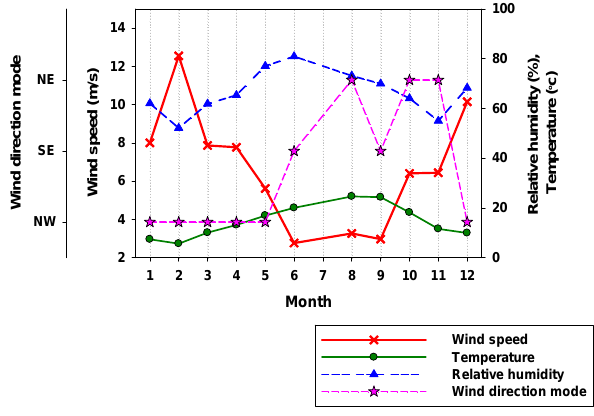
Fig. 4. Monthly variations of meteorological parameters includ- Figure 4 ing temperature, relative humidity, wind speed, and wind direction. Wind direction is represented as a mode divided into 8 from N to NW for 1-h data, and the wind mode in this study includes NE, SE, and